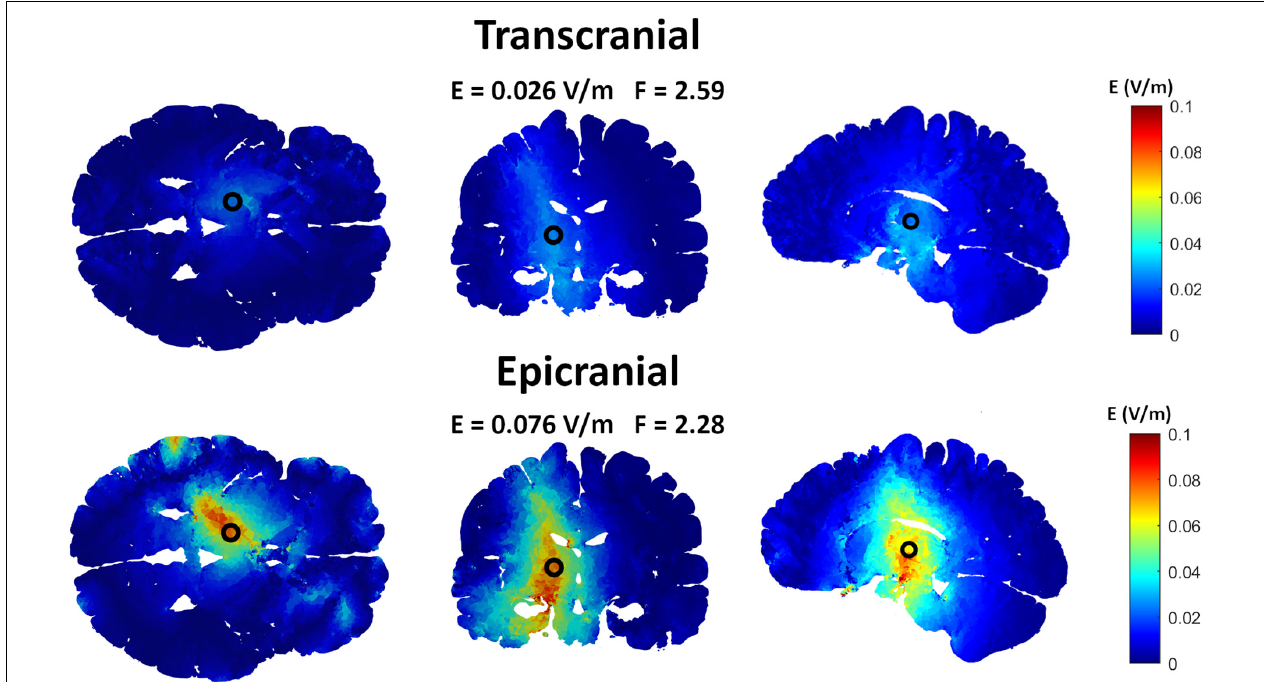
FIGURE 3 | Comparing interferential stimulation (IF) using transcranial electric stimulation (TES) electrodes to that using epicranial cortical stimulation (ECS) electrodes to target the ventral intermediate nucleus (VIM). The upper row shows the electric field distribution obtained by the TES grand optimal electrode configuration while the lower row shows that obtained by the ECS grand optimal electrode configuration. Using ECS electrodes, the interferential fields show higher and more focused electric field compared to that using TES